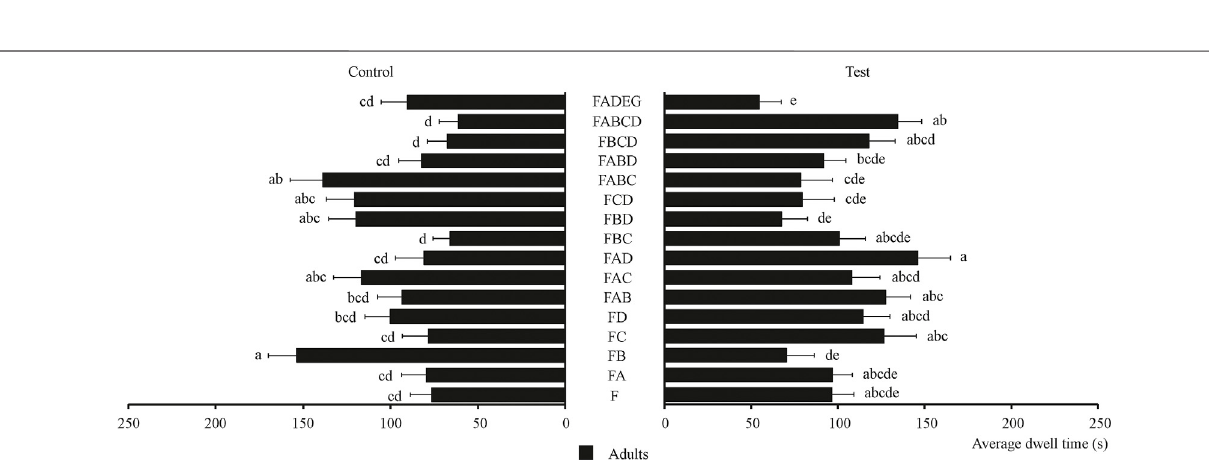
FIGURE 5 | Average dwell time of tobacco beetle adults in the combination of chemical substances and food attractants. Different lowercase letters in the fi gure represent the average dwell time of tobacco beetle adults with a signi fi cant difference at p < 0.05 in different combinations. Error bars shown in the fi gure represent mean ±